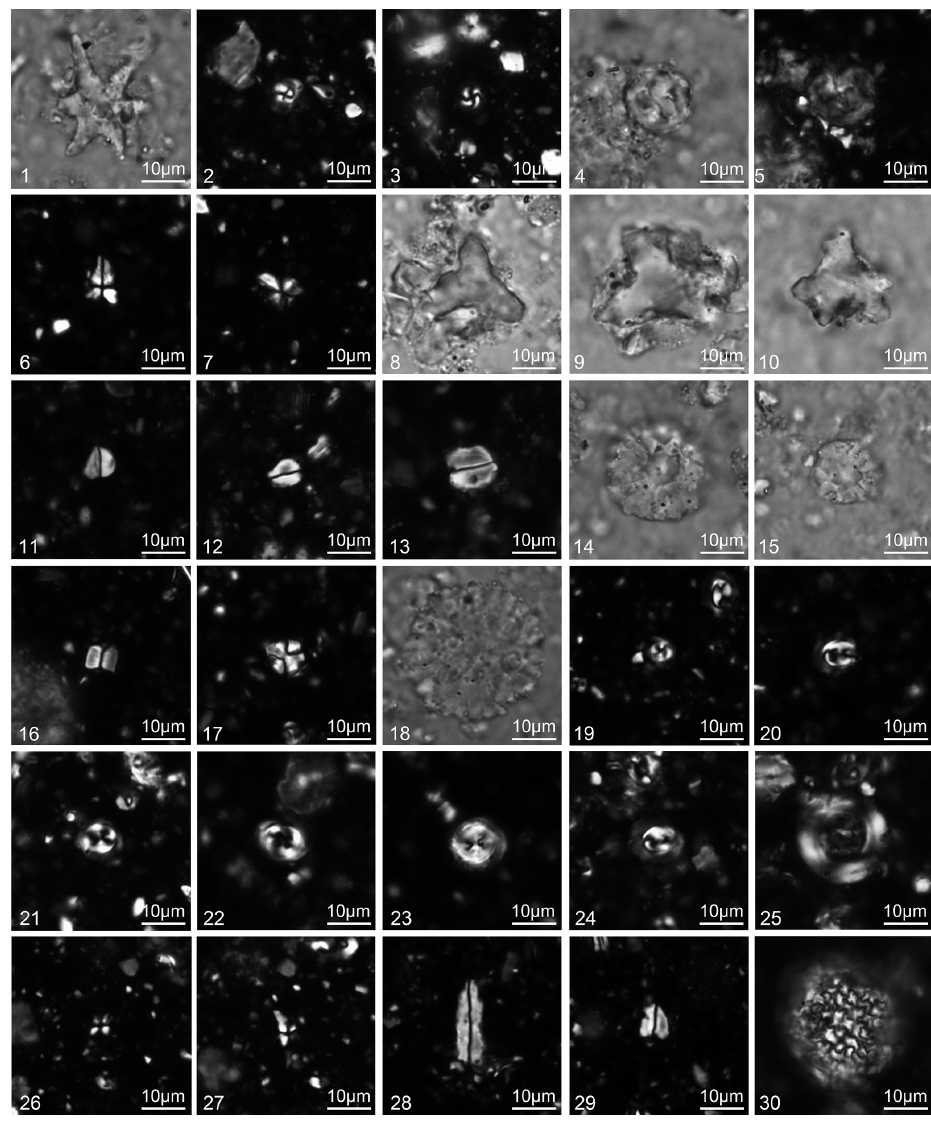
Plate 1. Images of selected calcareous nannofossil taxa from samples of the Cicogna section. Scale bar 10µm. 1. Discoaster lodoensis (Bramlette and Riedel, 1954). Parallel light. Parallel nicols. Sample CIC/07-492. 2–3. Girgisia gammation (Bramlette and Sullivan, 1961; Varol, 1989). Crossed nicols. Sample CIC/07-437. 4–5. Chiphragmalithus calathus (Bramlette and Sullivan, 1961): 4, parallel light; 5, crossed nicols. Sample CIC/07-447. 6–7. Sphenolithus radians (Deflandre in Grassé, 1952): 6, crossed nicols 0 ◦ ; 7, crossed nicols 45 ◦ . Sample CIC/07-437. 8. Tribrachiatus orthostylus (Shamrai, 1963). Parallel light. Sample 208-1262A-11H- 1, 149. Sample CIC/07-447. 9– 10. Tribrachiatus contortus (Stradner, 1958; Bukry, 1972). Parallel light. Sample CIC/07-335. 11–13. Zyghrablithus bijugatus (Deflandre in Deflandre and Fert, 1954; Deflandre, 1959). Crossed nicols. Sample CIC/07-437. 14. Discoaster salisburgensis (Stradner, 1961). Parallel light. Sample CIC/07-335. 15. Discoaster diastypus (Bramlette and Sullivan, 1961). Parallel light. Sample CIC/07-335. 16. Fasciculithus tympaniformis (Hay and Mohler in Hay et al., 1967). Crossed nicols. Sample CIC/07-335. 17. Octolithus multiplus (Perch-Nielsen, 1973; Romein, 1979). Crossed nicols. Sample CIC/07-122. 18. Discoaster multiradiatus (Bramlette and Riedel, 1954). Parallel light. Sample CIC/07-122. 19. Toweius pertusus (Sullivan, 1965; Romein, 1979). Crossed nicols. Sample CIC/07-122. 20. Toweius occultatus (Locker, 1967; Perch-Nielsen, 1971). Crossed nicols. Sample CIC/07-122. 21. Toweius eminens (Bramlette and Sullivan, 1961; Perch-Nielsen, 1971). Crossed nicols. Sample CIC/07-029. 22. Toweius eminens (Bramlette and Sullivan, 1961; Perch-Nielsen, 1971). Crossed nicols. Sample CIC/07-029. 23. Toweius eminens (Bramlette and Sullivan, 1961; Perch-Nielsen, 1971). Crossed nicols. Sample CIC/07-122. 24. Prinsius bisulcus (Stradner, 1963; Hay and Mohler, 1967). Crossed nicols. Sample CIC/07-029. 25. Ericsonia robusta (Bramlette and Sullivan, 1961). Crossed nicols. Sample CIC/07-029. 26–27. Sphenolithus anarrhopus (Bukry and Bramlette, 1969): 26, crossed nicols 0 ◦ ; 27, crossed